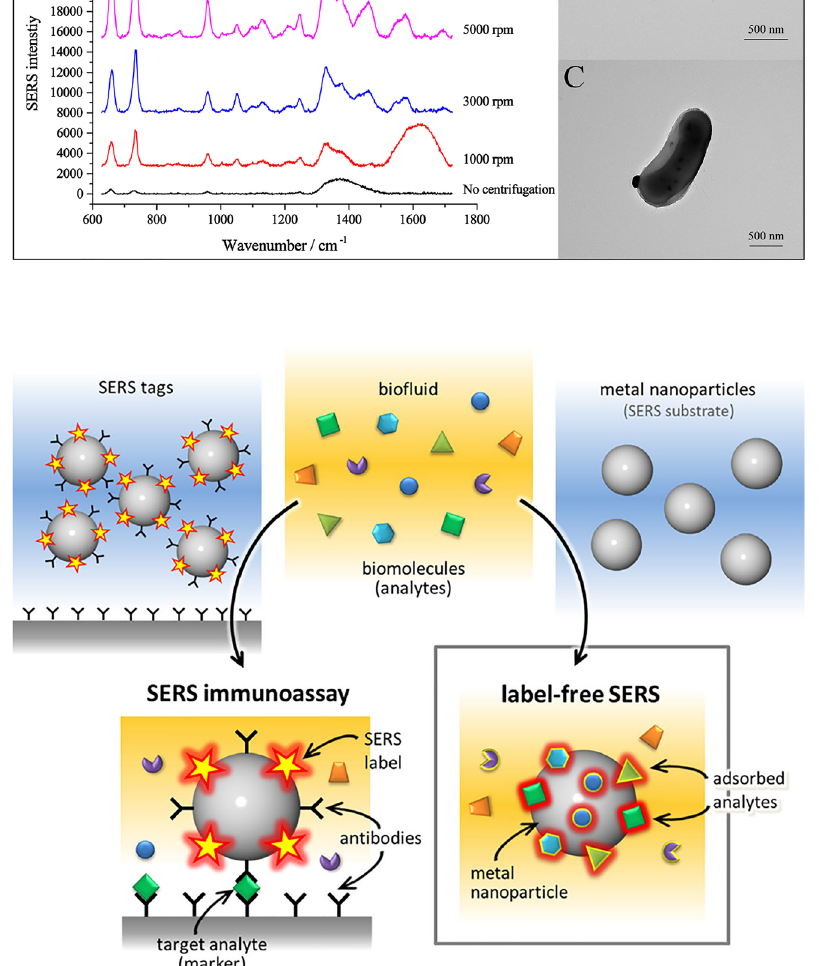
scattering (SERS) spectra of single Escherichia coli cells after centrifugation treatment.